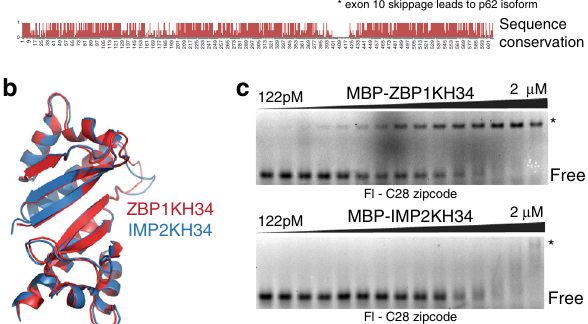
Fig. 1 ZBP1 and IMP2 overview and crystal structures. a Overall domain structure and sequence conservation of the IMP family members above. Below, sequence conservation across the IMP family members. b Ribbon diagrams overlaying the crystal structures of ZBP1KH34 in red (PDB: 3KRM) and IMP2KH34 in blue (this study, PDB:6ROL). c Representative EMSAs for wild-type C28 ß-actin zipcode RNA. The fi lled triangle represents a 1:1 serial dilution of ZBP1KH34 (top) and IMP2KH34